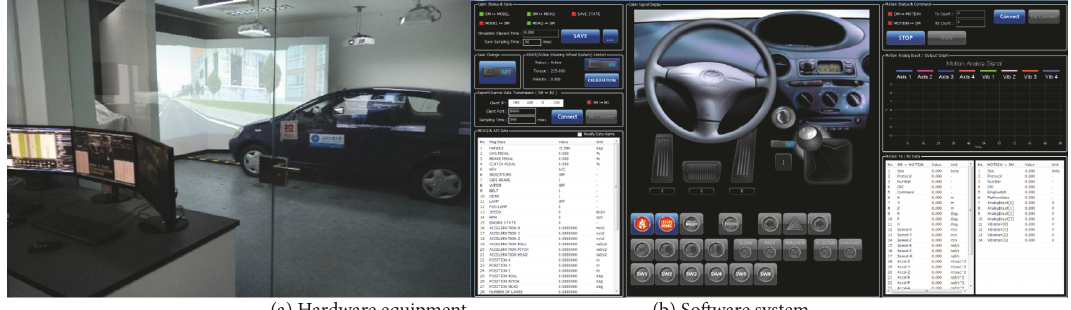
Figure 1: Driving simulator in Beijing University of